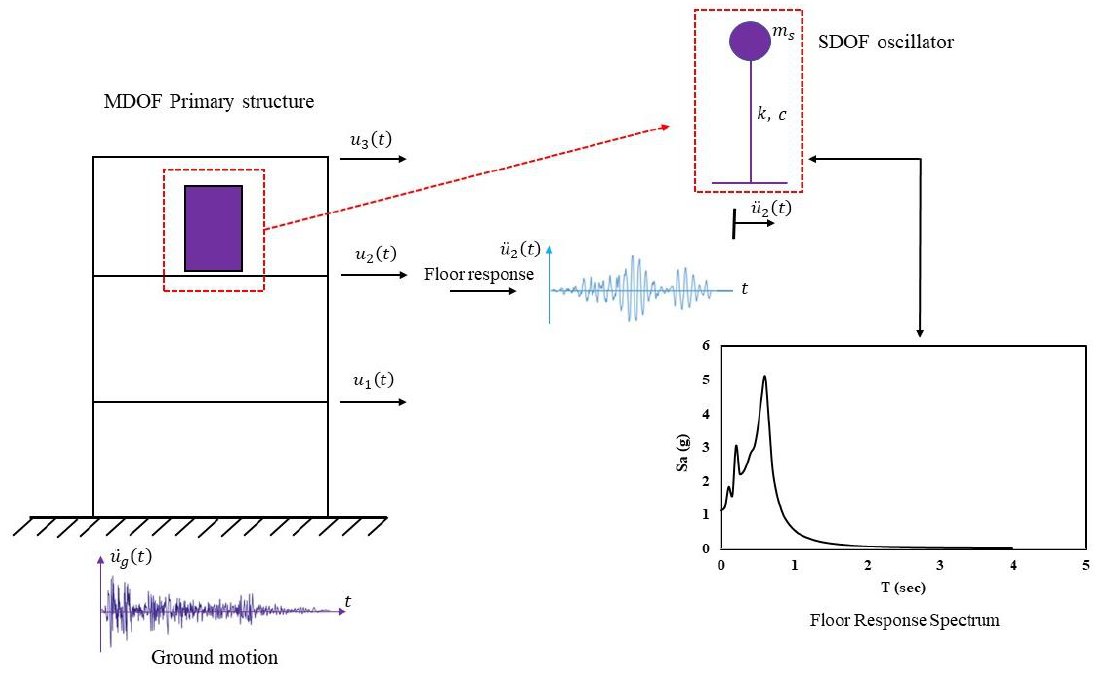
Figure 2. Generation of floor response spectrum.